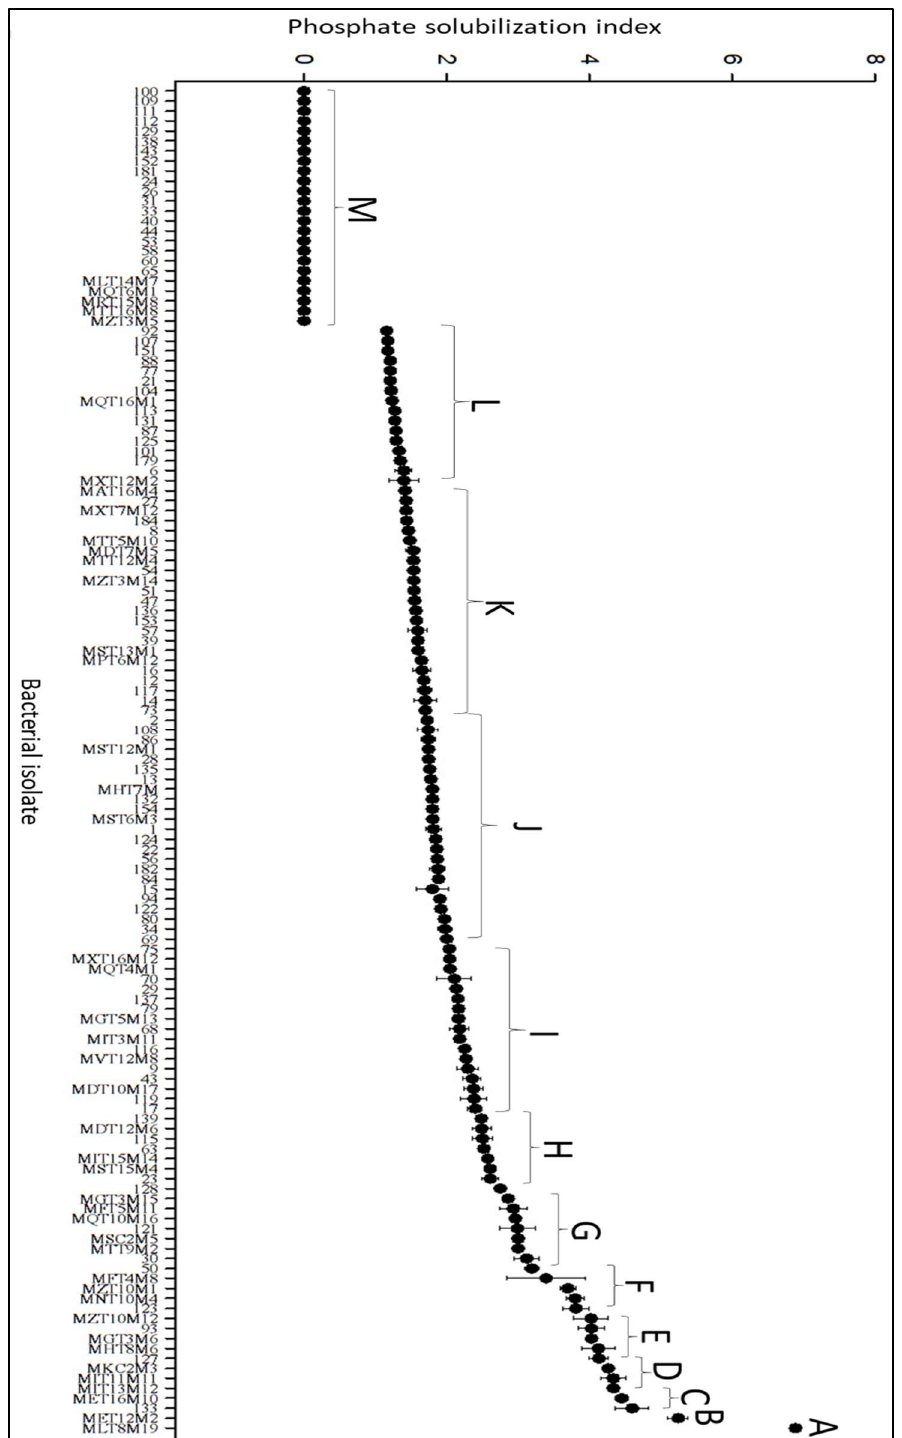
Figure 2. Phosphate solubilization by strawberry endophytic bacteria. Different letters differ significantly from each other by the Scott–Knot test, at 5% probability.